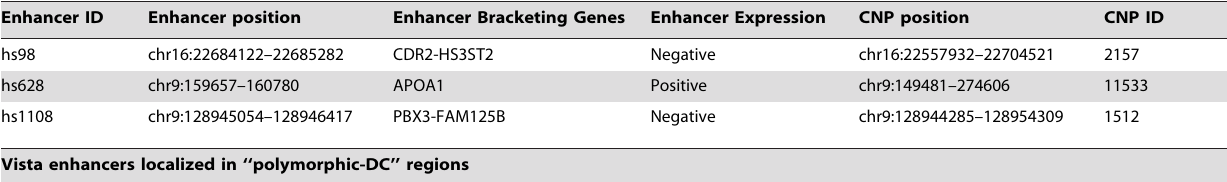
Vista enhancers localized in Copy Number Polymorphism (CNP)